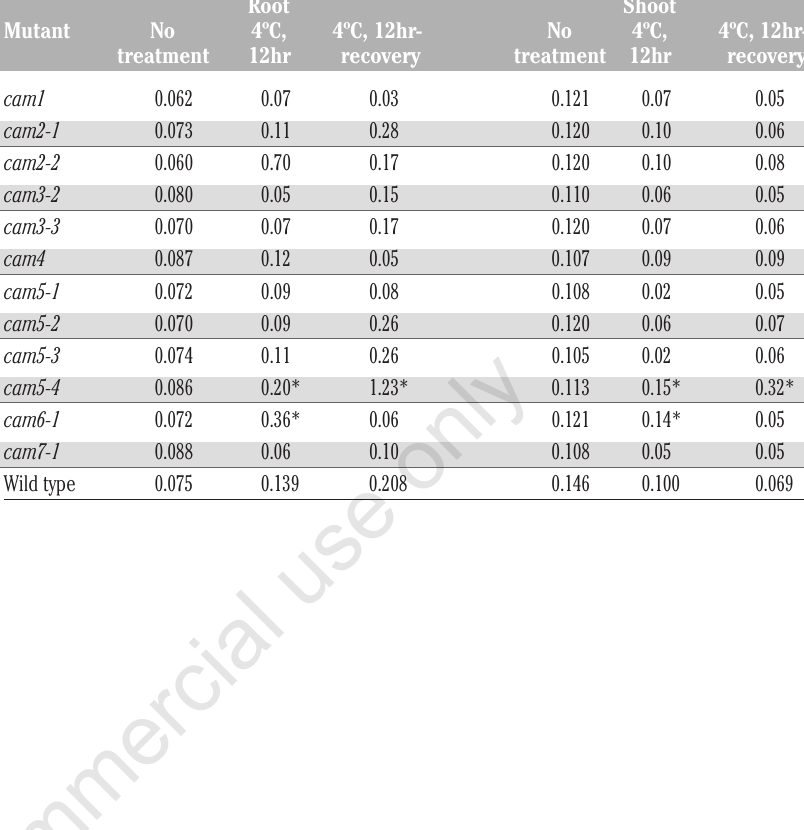
Table 3. Oxidative damage for all cam mutants under cold (4ºC, 12 hours) treatments in A.thaliana. The malonaldehyde (MDA) level was determined in root and shoot tissues by the thiobarbiturate reactive substances assay describe in materials and methods. Two set of seedlings were treated at 4ºC for 12 hours. One set was used immediately for meas- urement of MDA level, while the other set was allowed to recover for 2 days under con- tinuous light at 25°C before determination of MDA level (nmol/mg FW). Mutants with (*) represent the significant sensitivity (P<0.05).